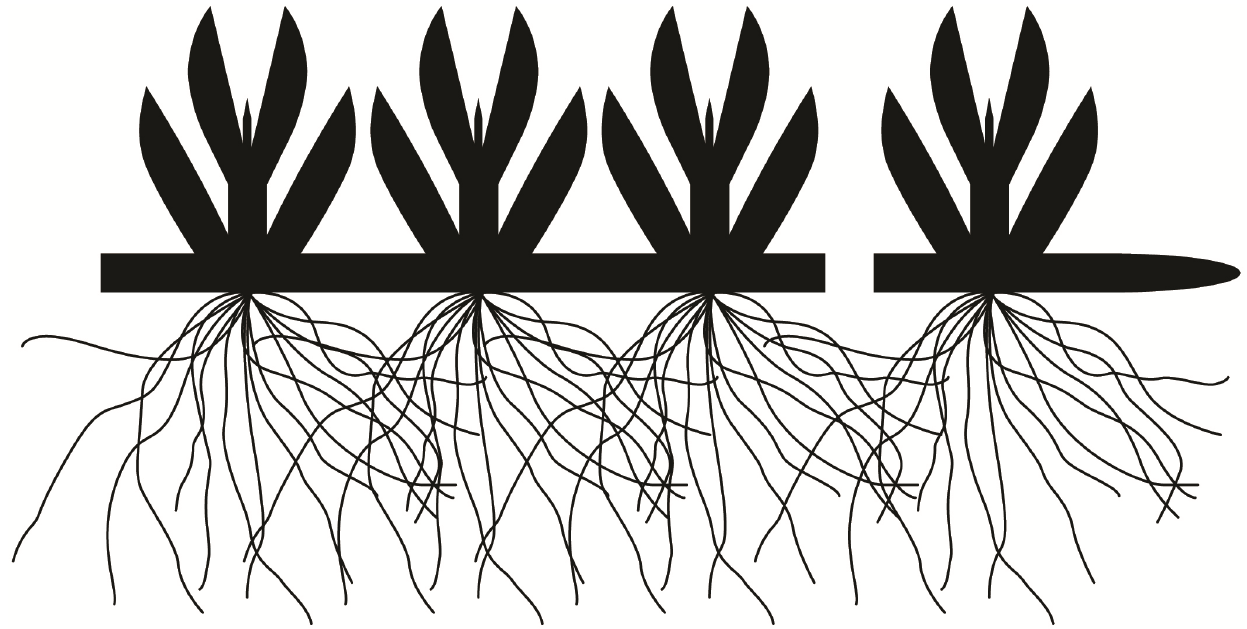
Figure 1. Collection of adult plants of C.edulis.